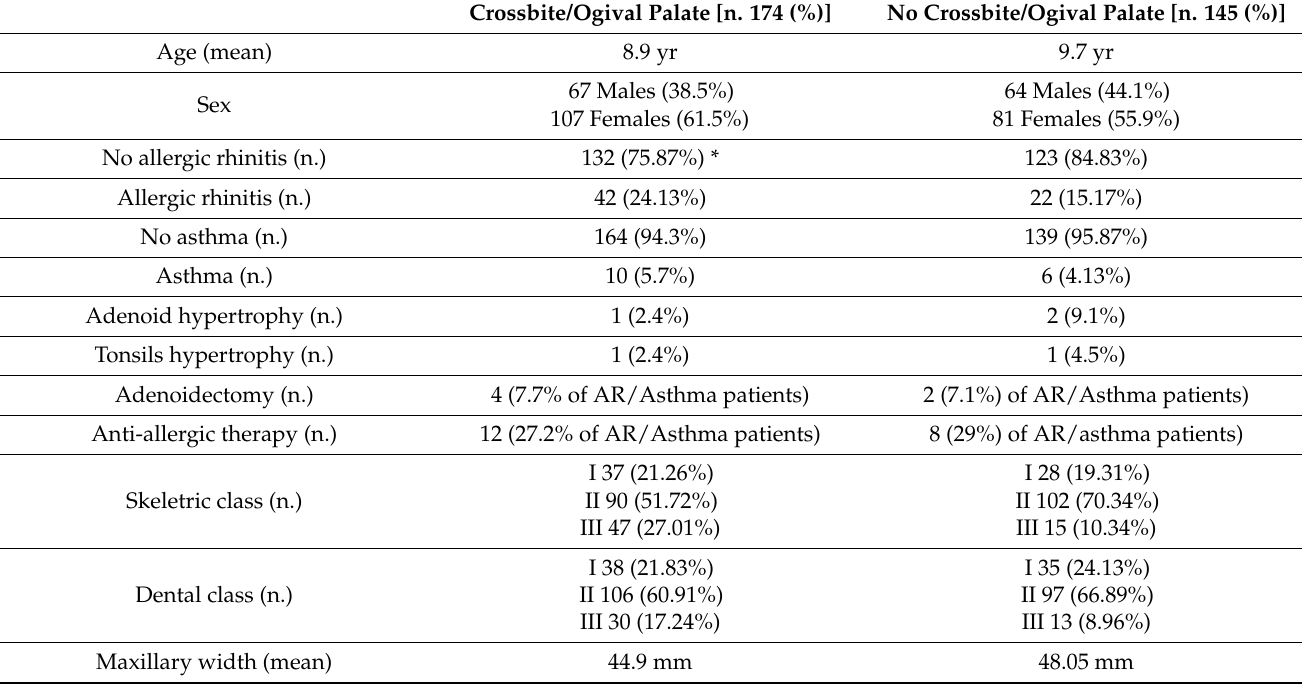
Table 1. The number of children (%) affected by AR and asthma in the study and control groups (* p = 0.05 for AR; p = 0.61 for asthma).